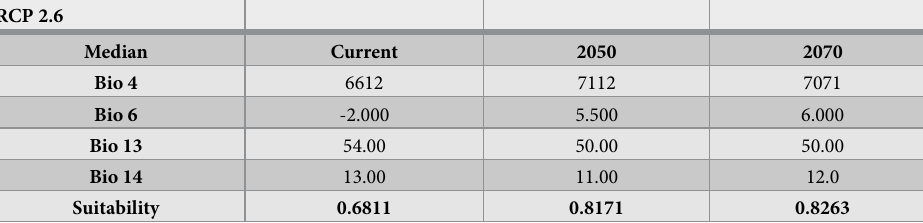
Table 2. Evolution of the median values for the selected bioclimatic variables under the RCP 2.6 scenario. The evolution of the suitability medians is also shown on the bottom row. All the values are taken at the current locations of G . bermejoi